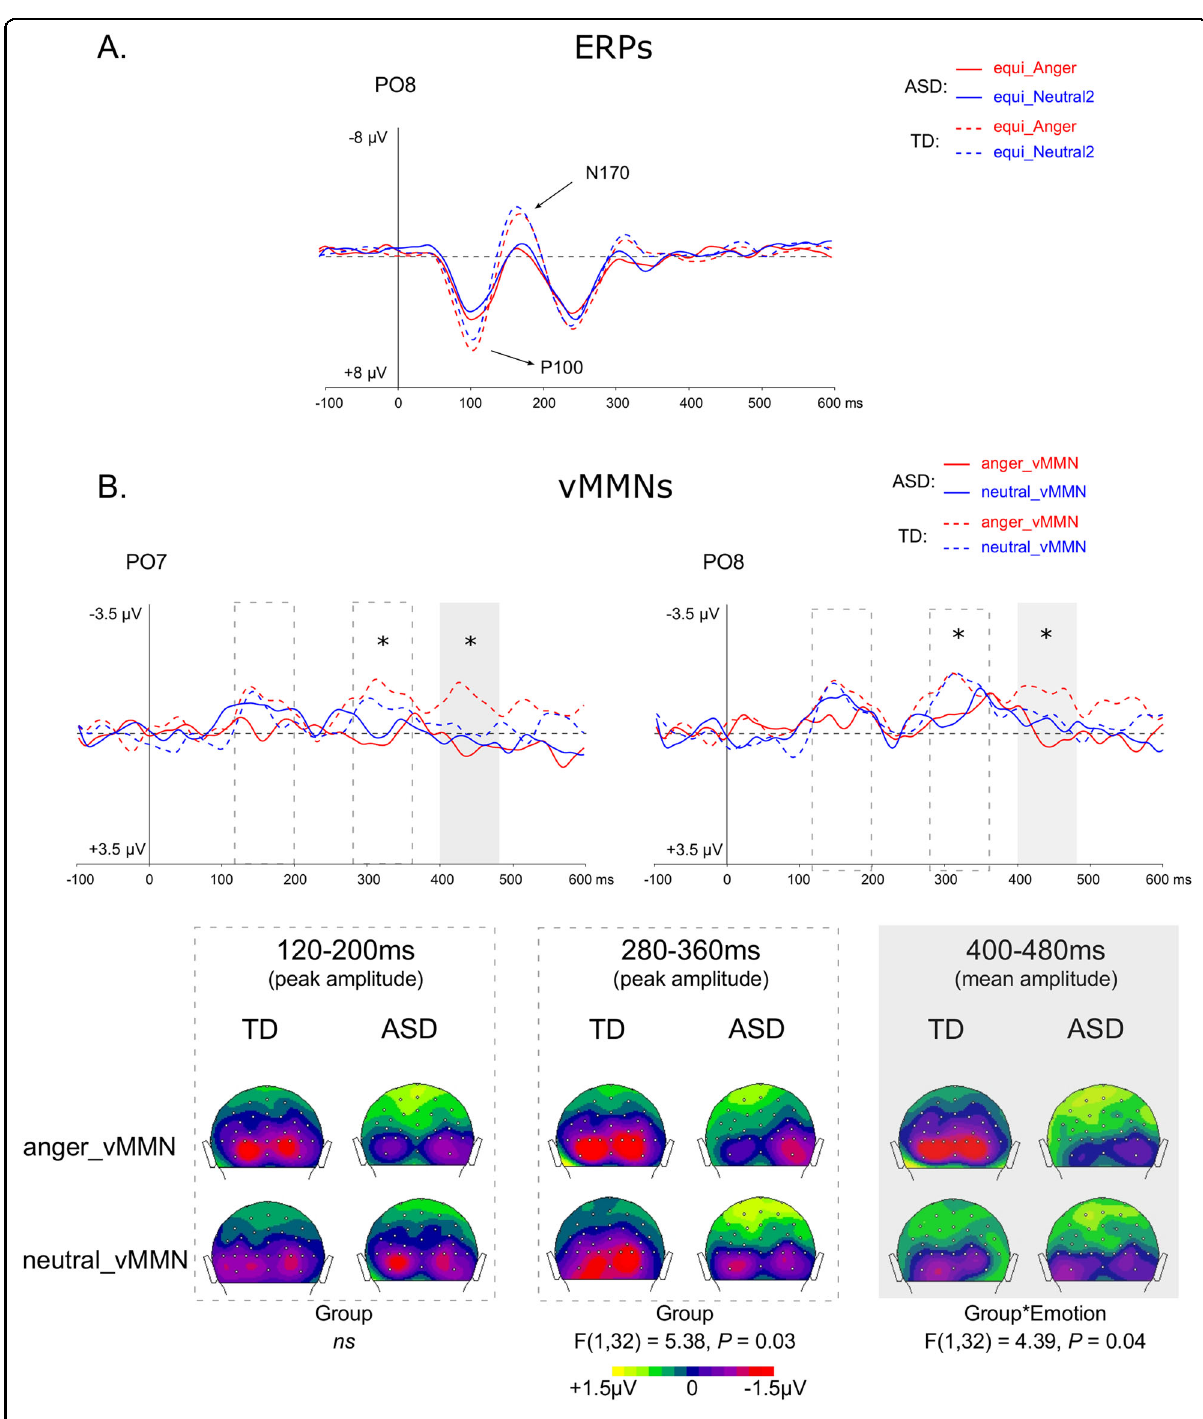
Fig. 2 Sensory ERPs and vMMNs for each condition and group over parieto-occipital electrodes. A Grand-average ERPs at PO8 elicited by emotional (i.e., anger, red lines) and neutral (blue lines) stimuli presented in the equiprobable sequence for the ASD (plain lines) and TD (dotted lines) groups. P1 and N170 components are indicated by arrows. B On the top, grand-average vMMN at PO7 and PO8 elicited by emotional (angry, red lines) and neutral (blue lines) deviants for the ASD (plain lines) and for TD (dotted lines) groups. Gray rectangles represent the time windows in which analyses were performed (peak analyses for 120 – 200 ms and 280 – 360 ms and 400 – 480 ms for mean amplitude). On the bottom, 2D scalp topographies (back view) showing mean activity in selected time windows for